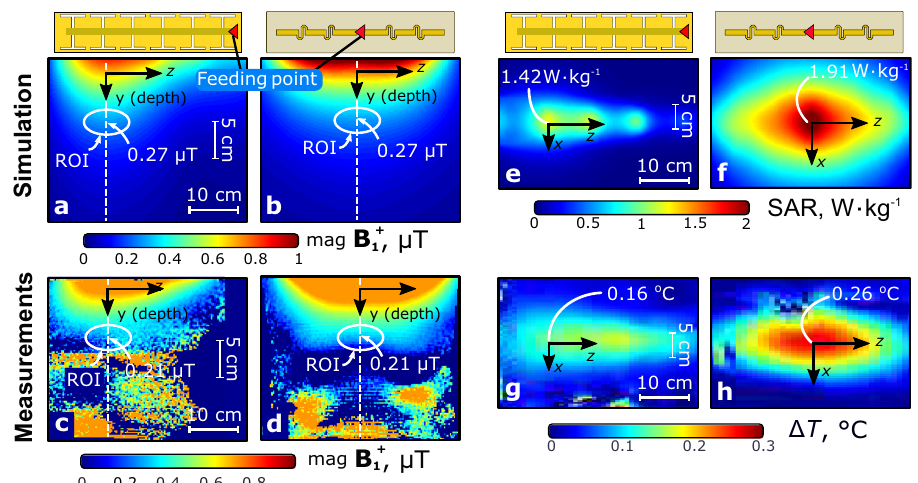
in the YZ -plane of the 1